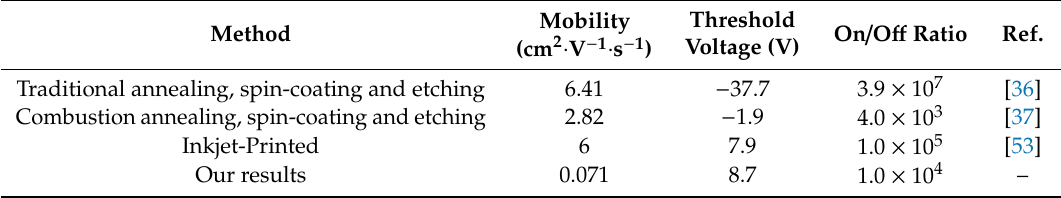
Table 1. Electrical parameters of InGaZnO TFTs fabricated by different methods.